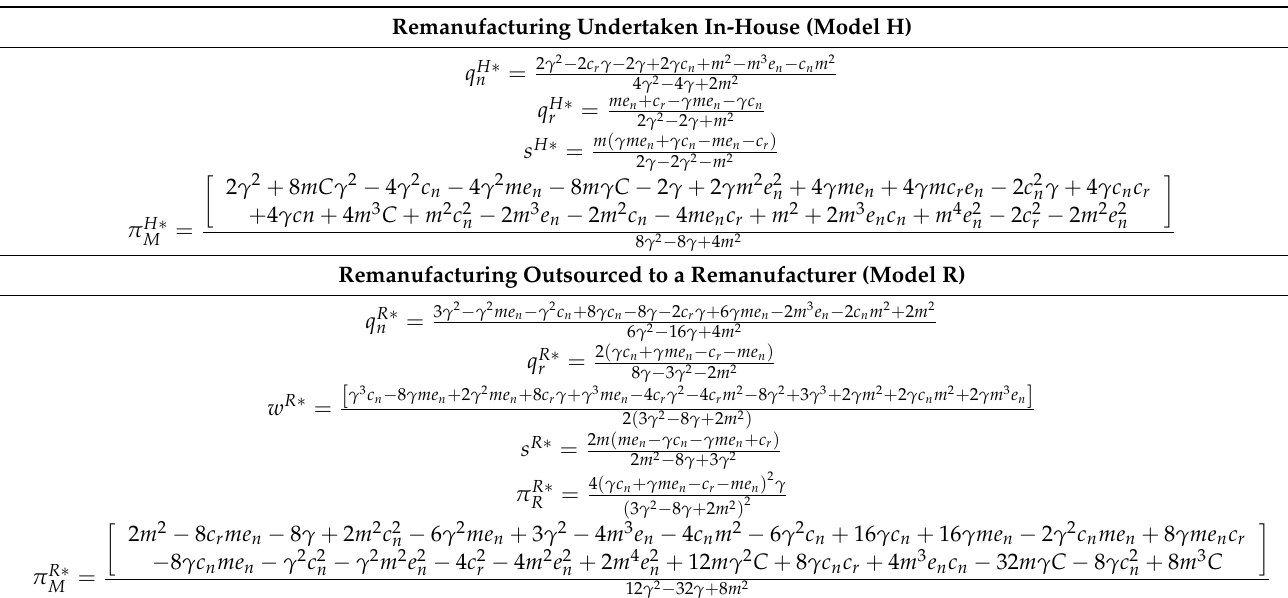
Table 3. Equilibrium decisions and